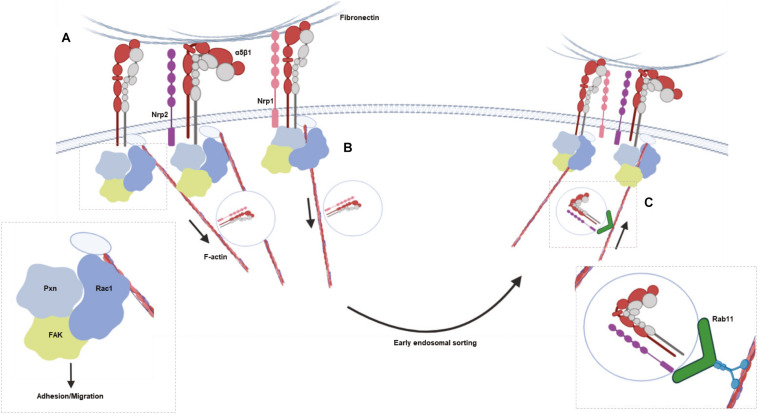
Schematic summarizing the major results. (A), NRP2 and ITGA5 share an interaction at the cell membrane, promoting EC adhesion and migration on FN matrices by regulating Rac1 activation. (B), NRP1 is known to selectively stimulate internalization of active α5β1 integrin from fibrillar adhesions along F-actin microfilaments to early endosomes in a Rab5 dependent manner. (C) NRP2 then regulates Rab11 dependent recycling of total ITGA5 back to adhesion sites along the actin cytoskeleton.